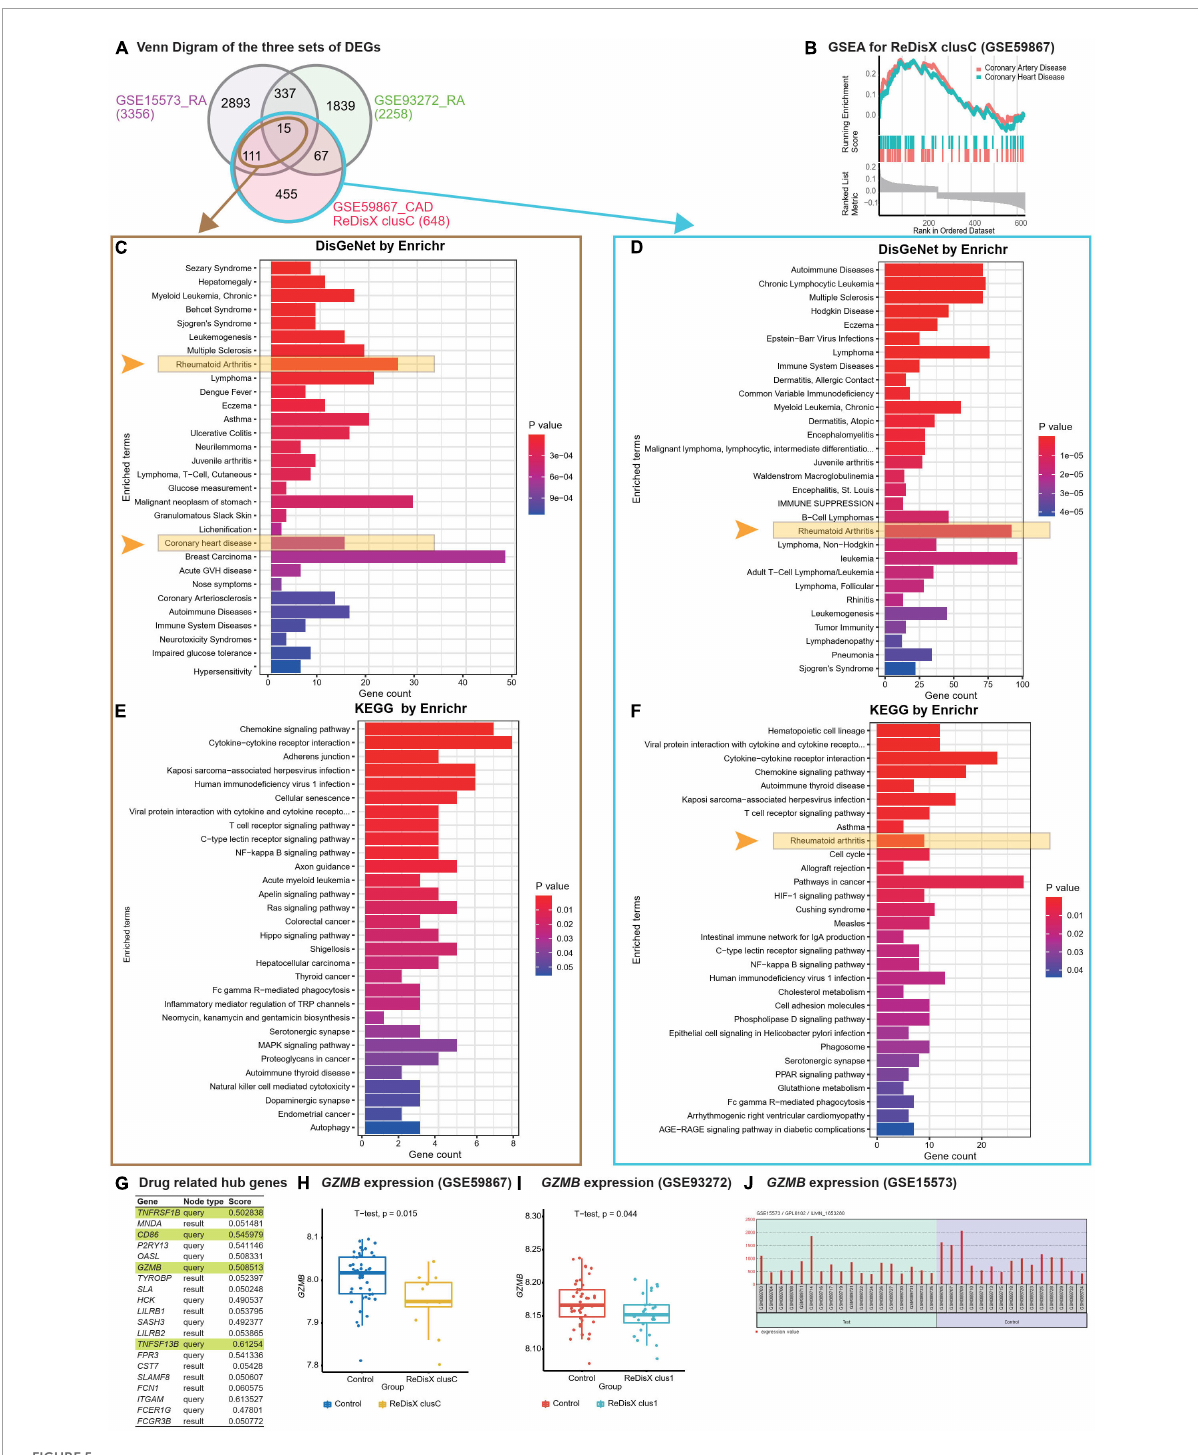
FIGURE5 ReDisX-based discovery of the subpopulation homogeneity across the RA and CAD patients. (A) Venn diagram of three sets of DEGs, GSE15573 (RA), GSE93272 (RA), GSE59867 (CAD) cluster C. (B) GSEA of ReDisX-based cluster C in GSE59867. (C) Disease Ontology (DO) enrichment using DisGeNet for the intersecting DEGs of GSE59867 (CAD) cluster C and GSE15573 using Enrichr. (D) DO enrichment of GSE59867 (CAD) cluster C DEGs. (E) Pathway enrichment for the intersecting DEGs of GSE59867 (CAD) cluster C and GSE15573 by KEGG. (F) Pathway enrichment for GSE59867 (CAD) cluster C DEGs by KEGG. (G) The list of drug-gene target-related identified hub genes from cluster C of GSE59867 (CAD). (H) Boxplot of GZMB expression in GSE59867, Control (blue), and ReDisX-based cluster C (yellow). (I) Boxplot of GZMB expression in GSE93272, Control and ReDisX-based cluster C (blue). (J) The expression value of GZMB within the patient and healthy controls from